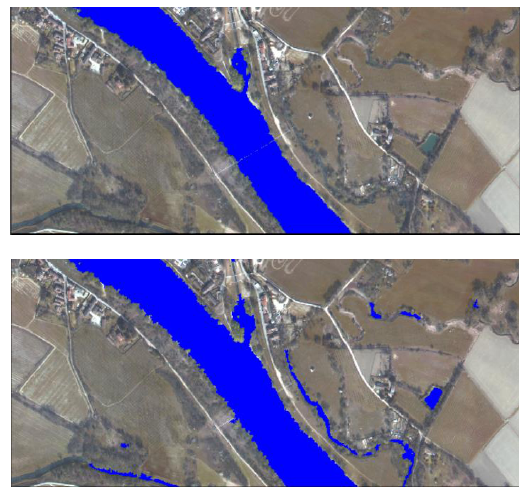
Figure 10. At the top, the water class before refinement, in the lower part the water class after refinement.